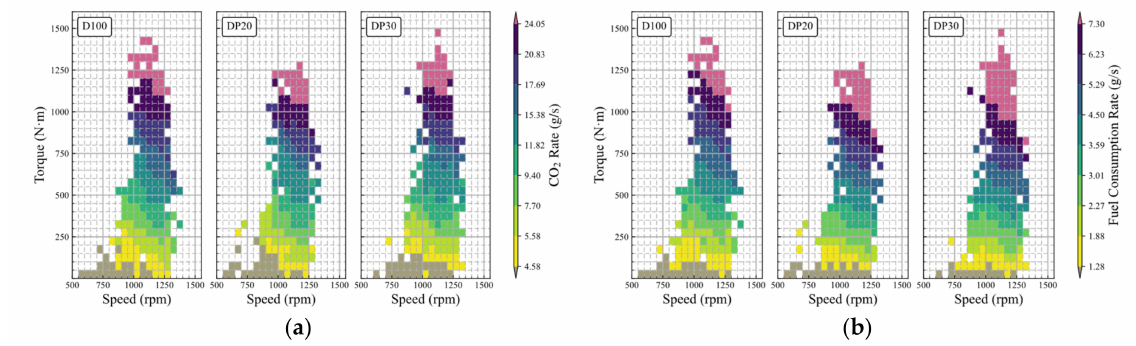
Figure 7. Transient maps of ( a ) CO 2 emission and ( b ) fuel consumption